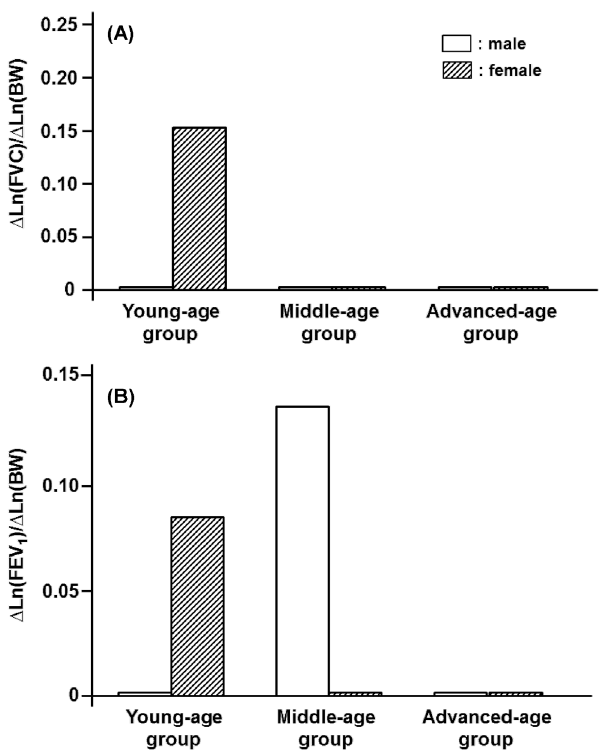
Figure 4. Age-specific contributions of body weight (BW) to FVC and FEV 1 estimated for three different age groups of both genders. (A): Partial regression coefficients of Ln(BW) for reference means of Ln(FVC) in young-, middle-, and advanced-age groups of either gender. They are designated as D Ln(FVC)/ D Ln(BW). (B): Partial regression coefficients of Ln(BW) for Ln(FEV 1 ) are designated as D Ln(FEV 1 )/ D Ln(BW).